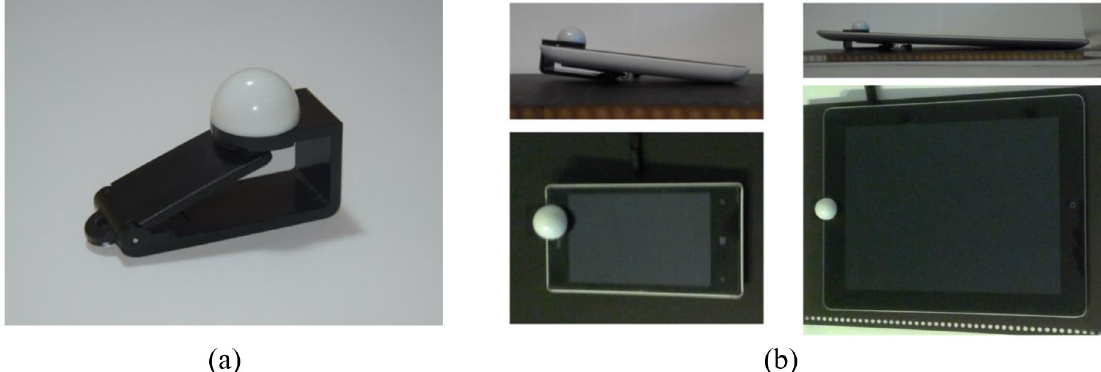
Fig. 1. (a) Device used as a light diffusor (Luxi for all). (b) Mobile devices: Nokia (left) and Ipad (right) with the diffuser dome